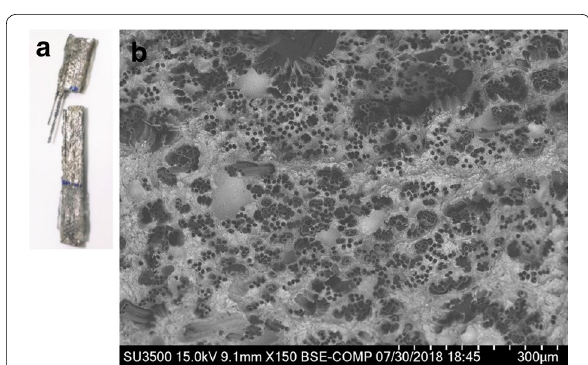
Figure 9 ( a ) Tensile specimen of FTP process and ( b ) the fracture morphology BSE image of 1 μm specimen